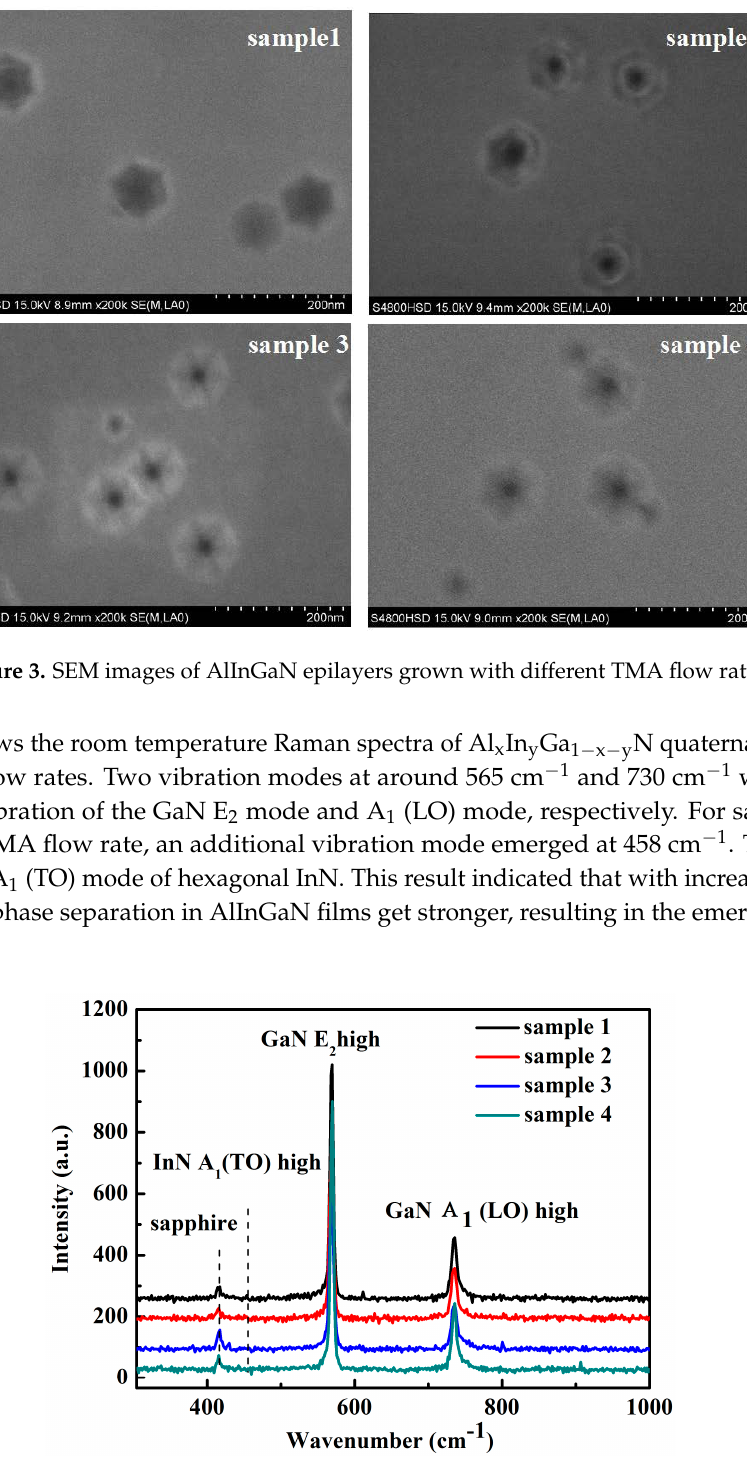
Figure 4. Raman spectra of the Al x In y Ga 1 − x − y N quaternary alloy samples at room temperature.